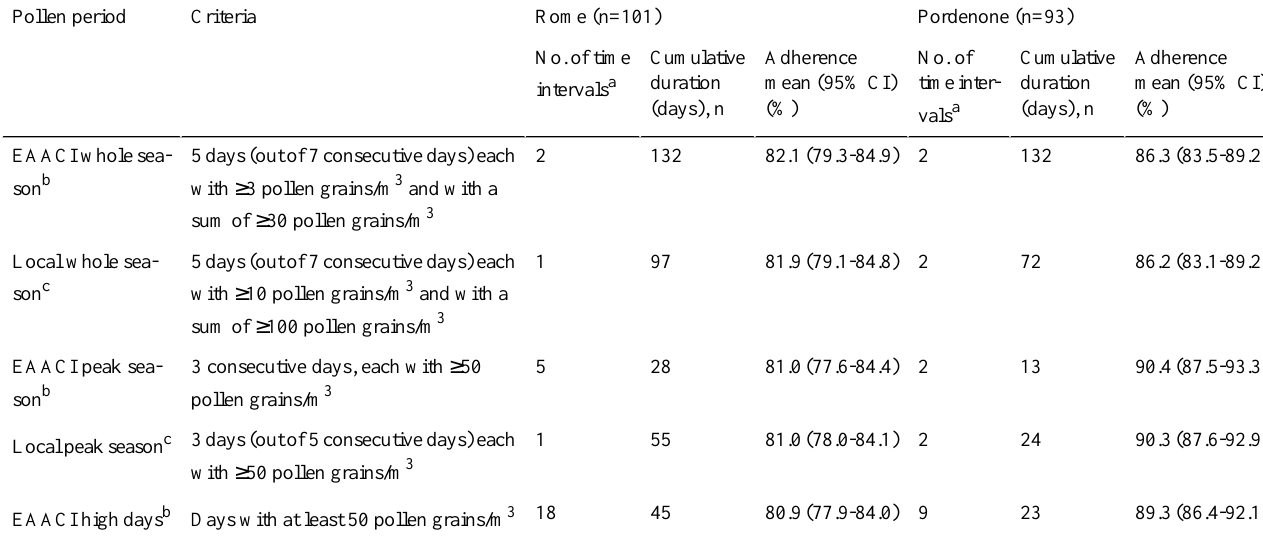
Table 2. Grass pollen period criteria and duration, by study